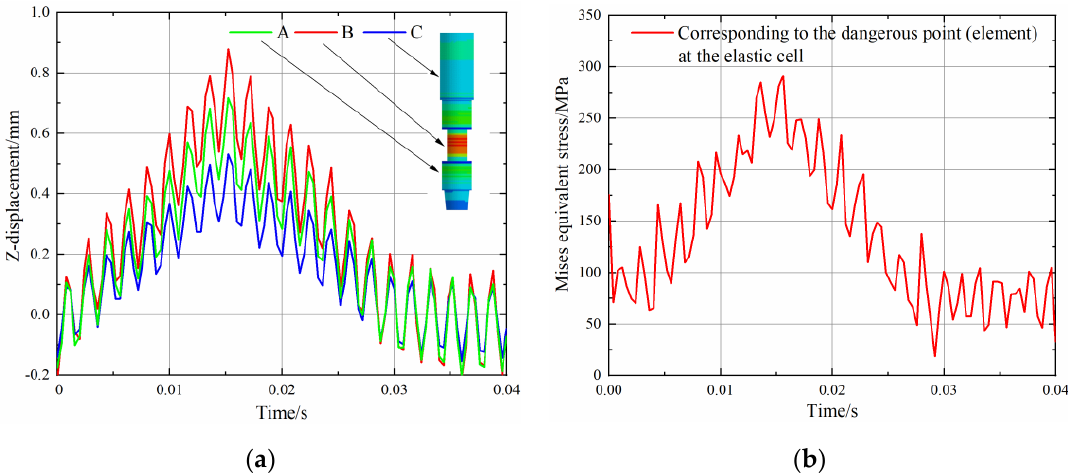
Figure 15. Time-history response of the structure under impact load: ( a ) displacement ( b ) maximum of Mises stress.